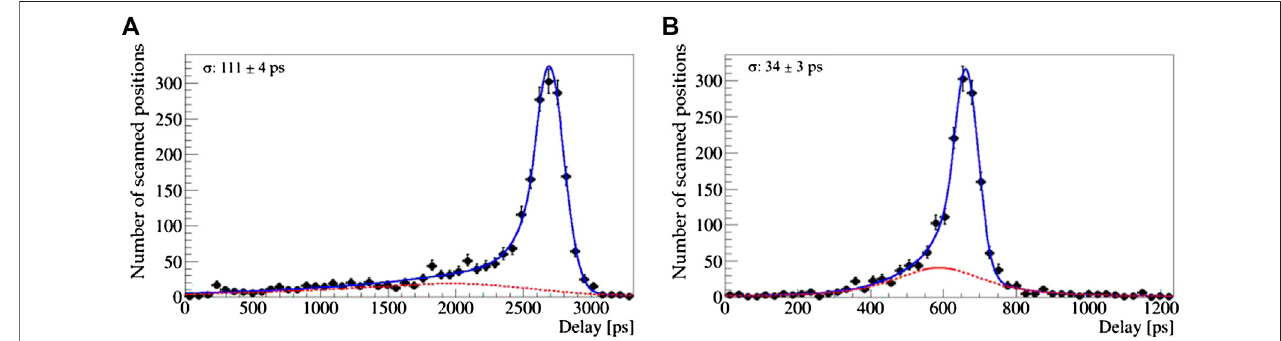
FIGURE 9 | Distribution of the delay between the time reference de fi ned by the photodiode and the time marker on Sensor A (A) and Sensor B (B) . The superimposed fi t, used to determine the resolution of the main peak, describes the dataset as the combination of a signal component modelled with a Crystal Ball function, and a background component modelled with the empirical function de fi ned in Eq. 3